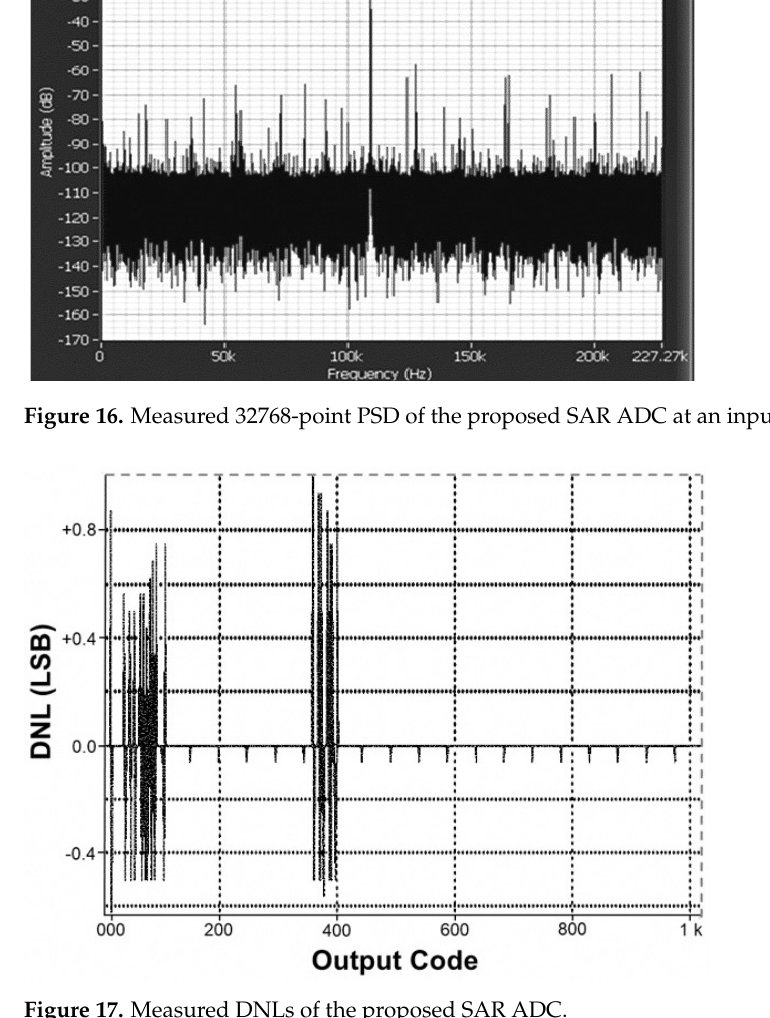
Figure 18. Measured INLs of the proposed SAR ADC.